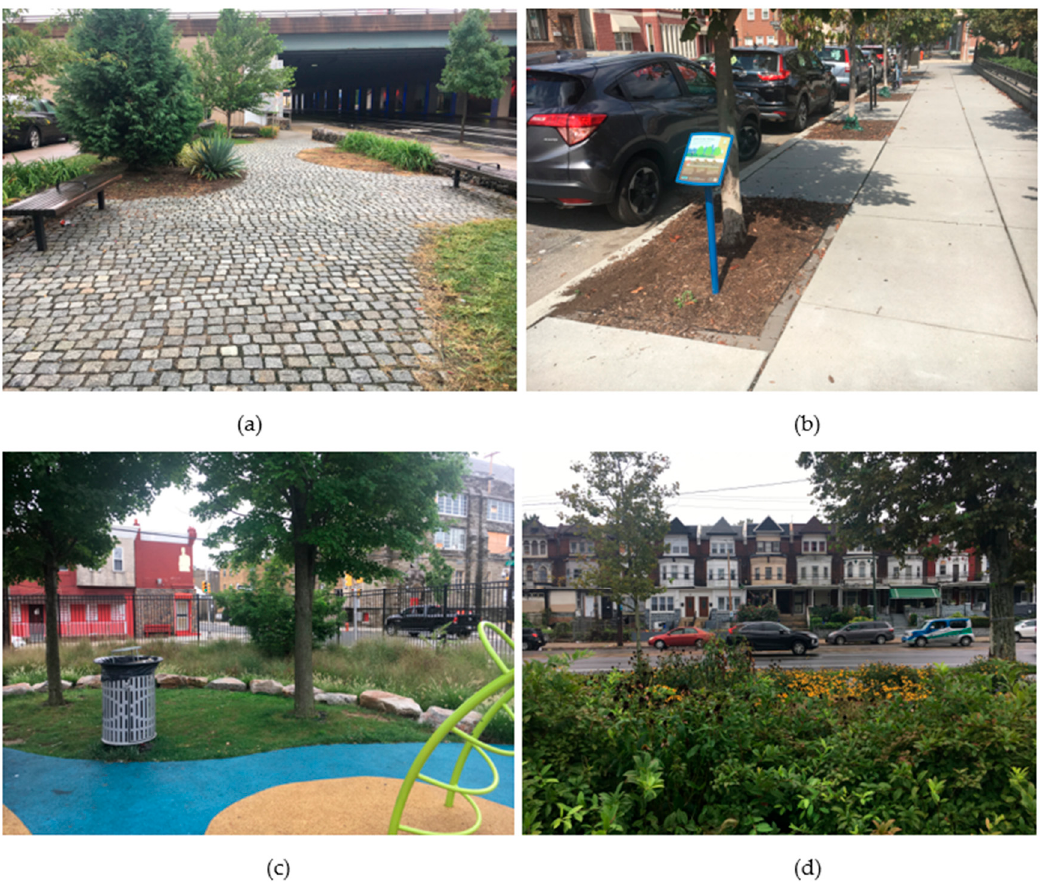
Figure 3. Four examples of highly visible and well-maintained GSI projects in Philadelphia. ( a ) a porous paving project designed as passive recreational area with seating arrangement and designed landscape; ( b ) a series of tree trench projects with a visible signage and wide sidewalk; ( c ) a bioswale designed as part of a play space with a visible trash can; ( d ) a rain garden next to a busy road with vibrant plants and flower beds. Photos by Shane Walsh.